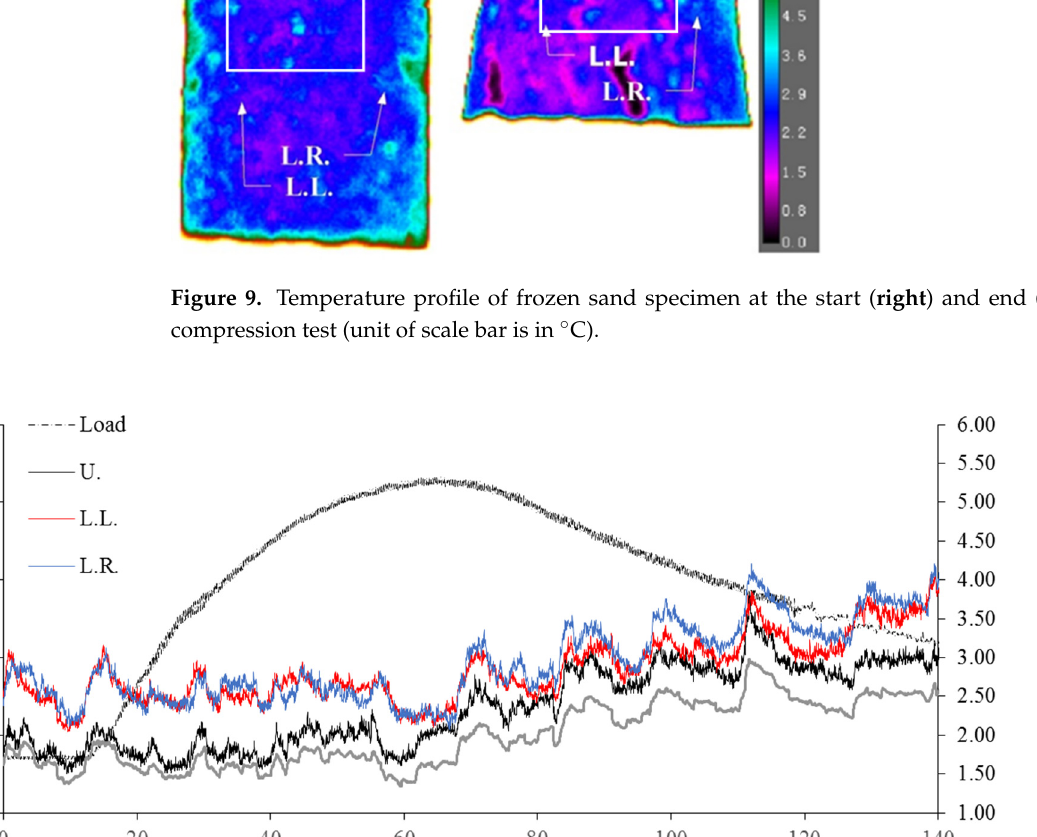
Figure 9. Temperature profile of frozen sand specimen at the start ( right ) and end ( left ) of the com- pression test (unit of scale bar is in °C).